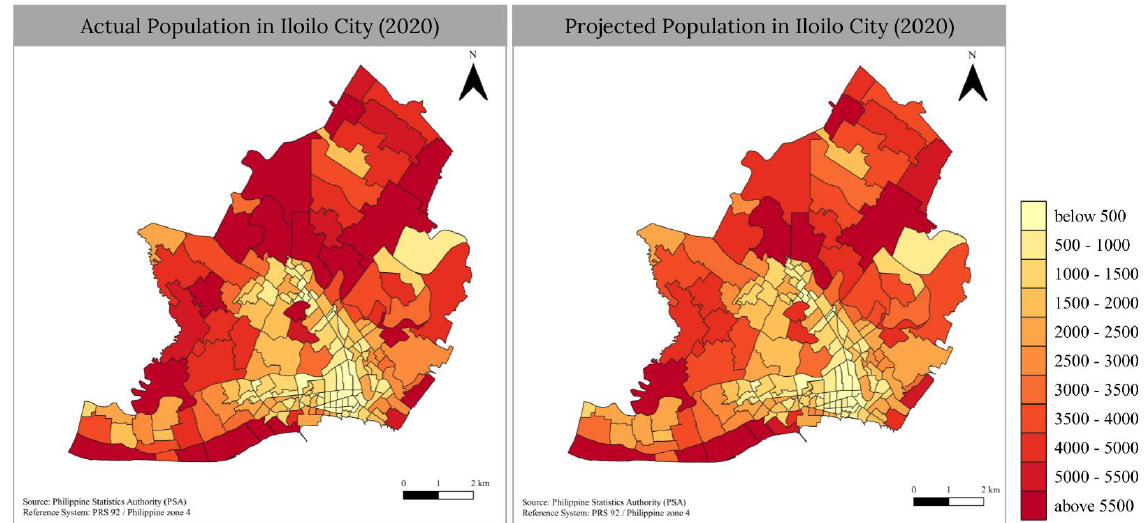
Figure 5. Comparison of actual vs projected total population in Iloilo City for 2020.